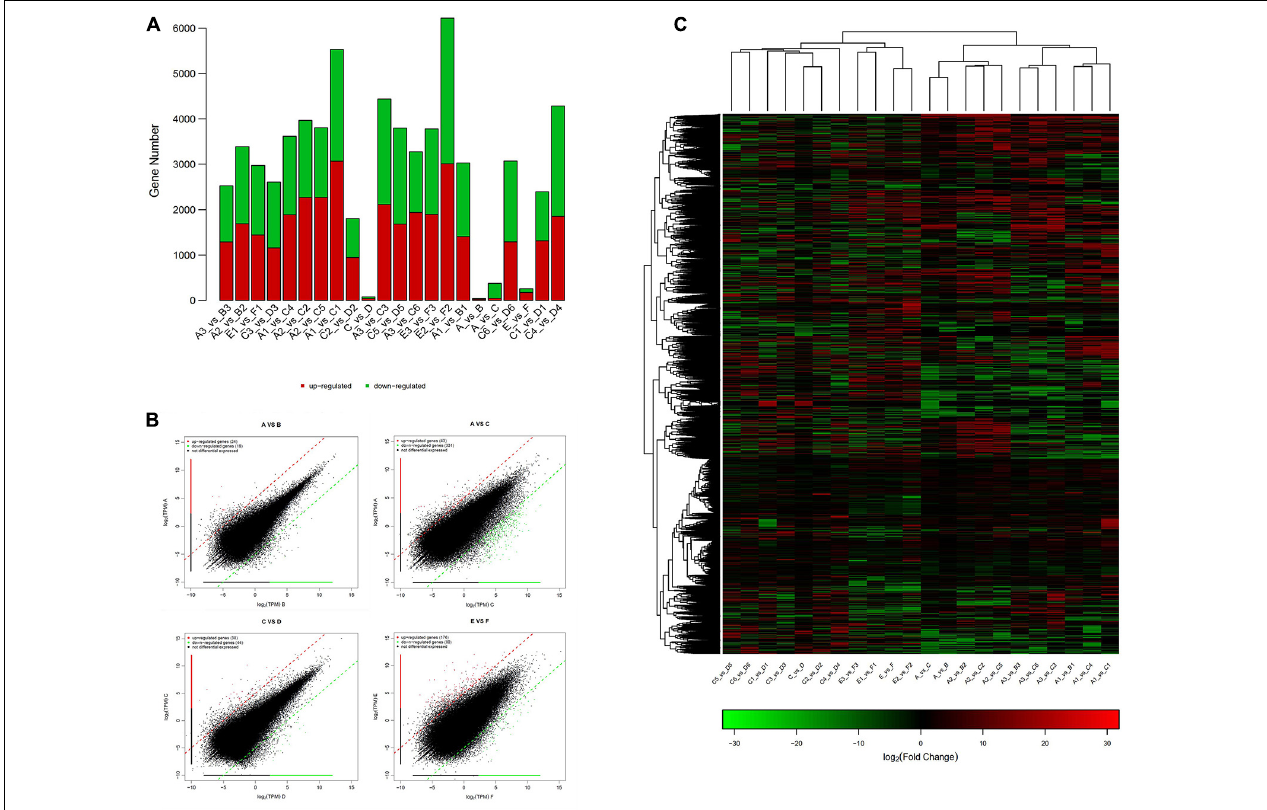
FIGURE 5 | The differential gene expression analysis of P. praeruptorum . (A) The amount of up- and downregulated DEGs in different groups. (B) Scatter plots of the DEGs in A vs. B, A vs. C, C vs. D, and E vs. F. (C) Heatmap of the differential genes between groups based on fold change values. The red denotes upregulated expression, and the green denotes downregulated